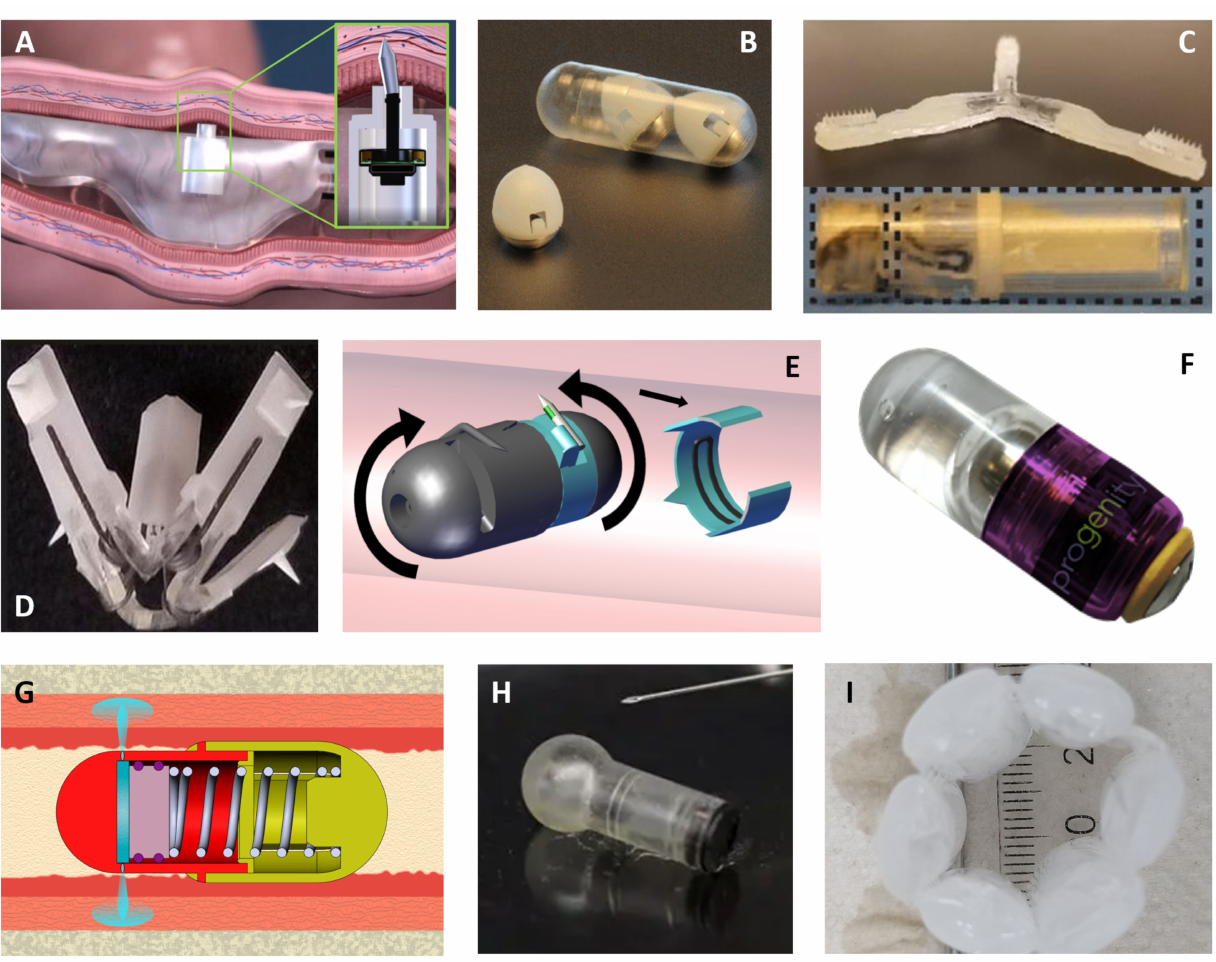
Figure 2. Devices designed to deliver biologics in the gastrointestinal tract. ( A ) RaniPill™ capsule delivering to the small intestine via a microneedle (Image provided by Rani Therapeutics) [147,148]; ( B ) SOMA device prototypes aimed to deliver in the stomach wall (Photo credit and copyright: Felice Frankel) [149]; ( C ) LUMI device unfolded ( top ) and inside the enteric coated capsule ( bottom ) (Adapted with permission from [150], Nature Medicine, 2019); ( D ) Flower-like device